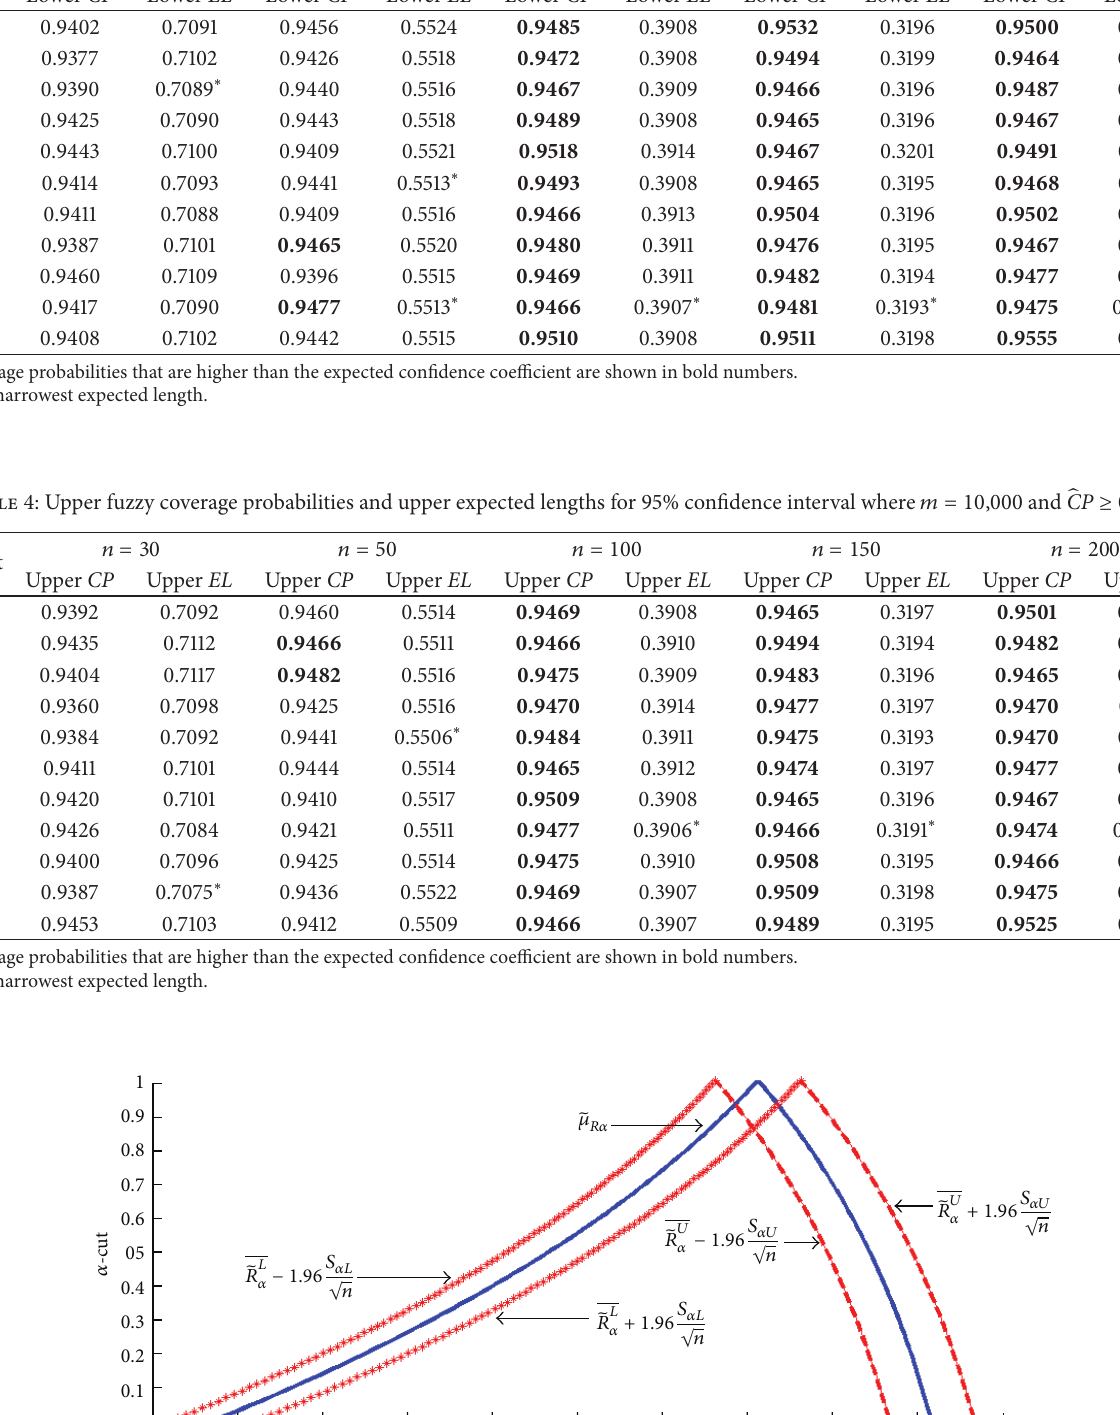
Table 3: Lower fuzzy coverage probabilities and lower expected lengths for 95% confidence interval where 𝑚 = 10 , 000 and